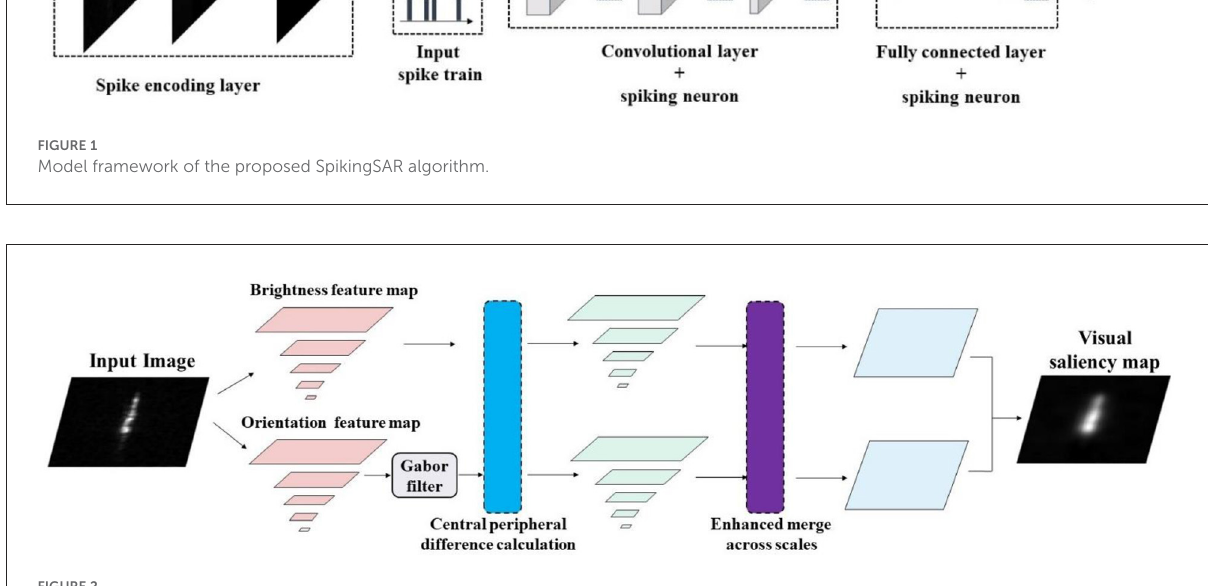
FIGURE2 Visual attention model